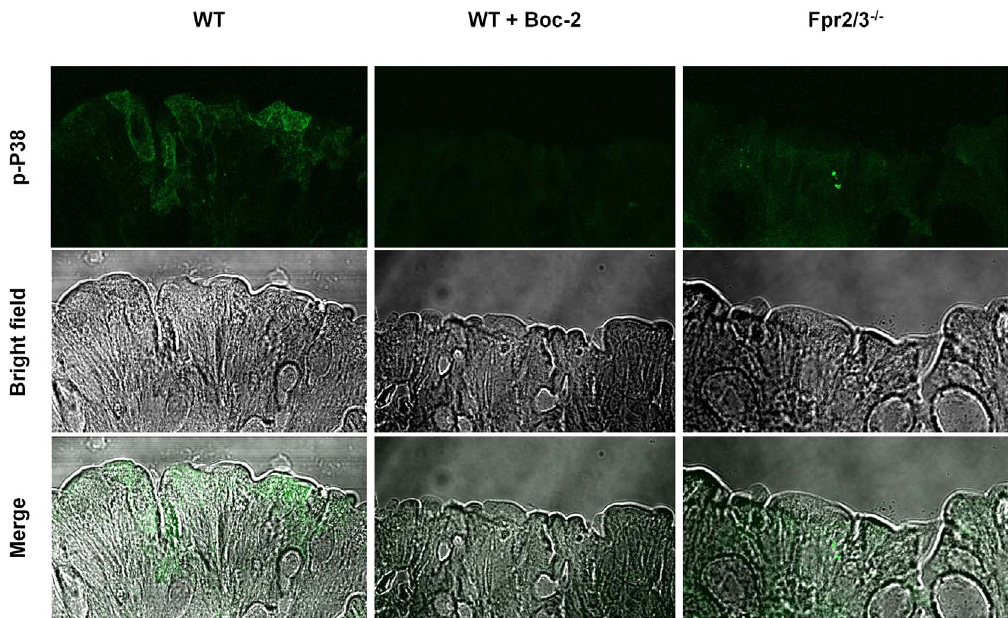
Fig. 9. Reduced p-p38 staining in the colon of Boc2-treated C57BL/6 and Fpr2/3 -/- mice. Immunofluorescence (top panel) of phospho-p38 of intestinal whole mount preparations (as described in Material and Methods) in either PBS-vehicle treated, Boc2 treated or Fpr2/3 -/- intestinal mucosa. The middle and bottom panel show the bright field and the overlay pictures of the same